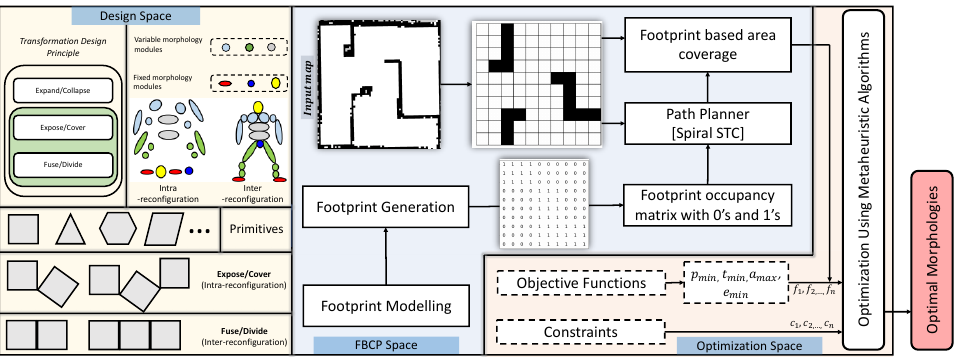
Figure 1. Overview of the proposed framework with design space of n-Omino and optimization space for selecting optimal morphology for a given environment or